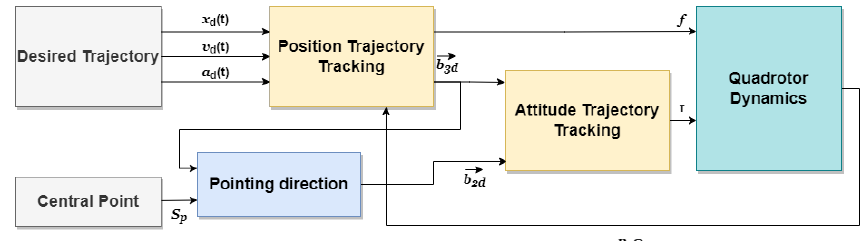
Figure 7. The structure of the geometric